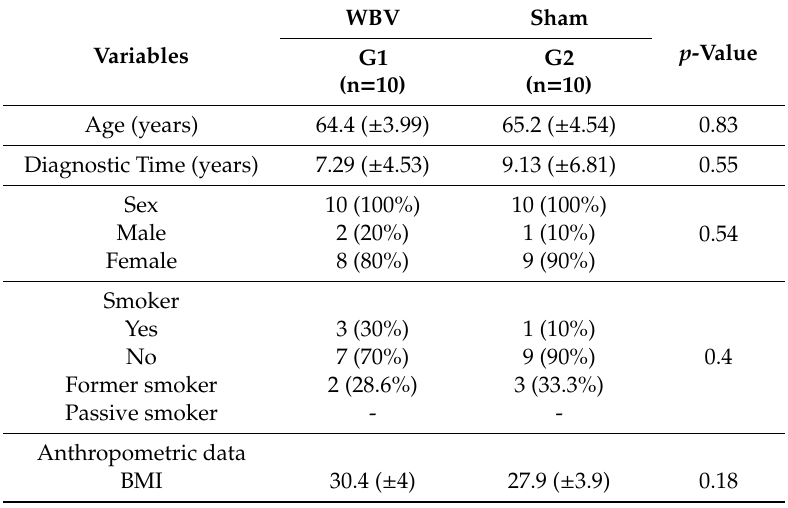
Figure 2. Flow chart which describes the recruitment, randomization, and allocation of patients. Table 1. Baseline characteristics of patients in the whole-body vibration (WBV) and sham groups.